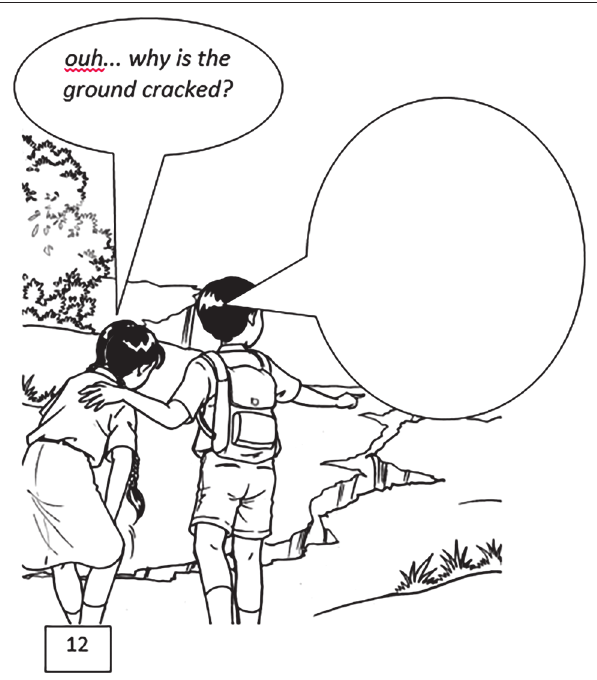
FIGURE 5 : Scene 12 is designed to evoke skills in arguing for cracked soils as the initial indicator of landslide activity.